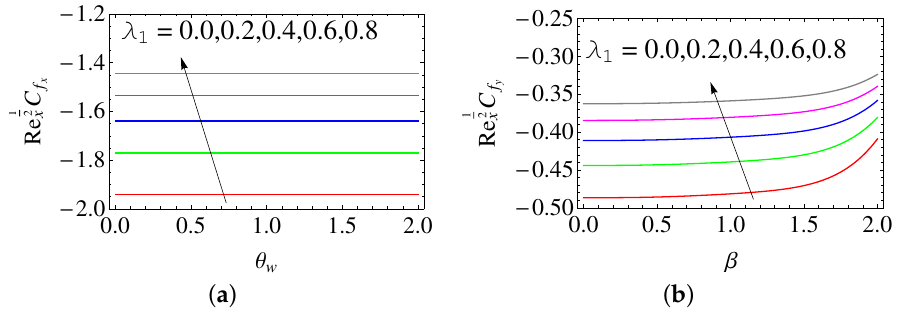
1 2 x C f and ( b ) Re x